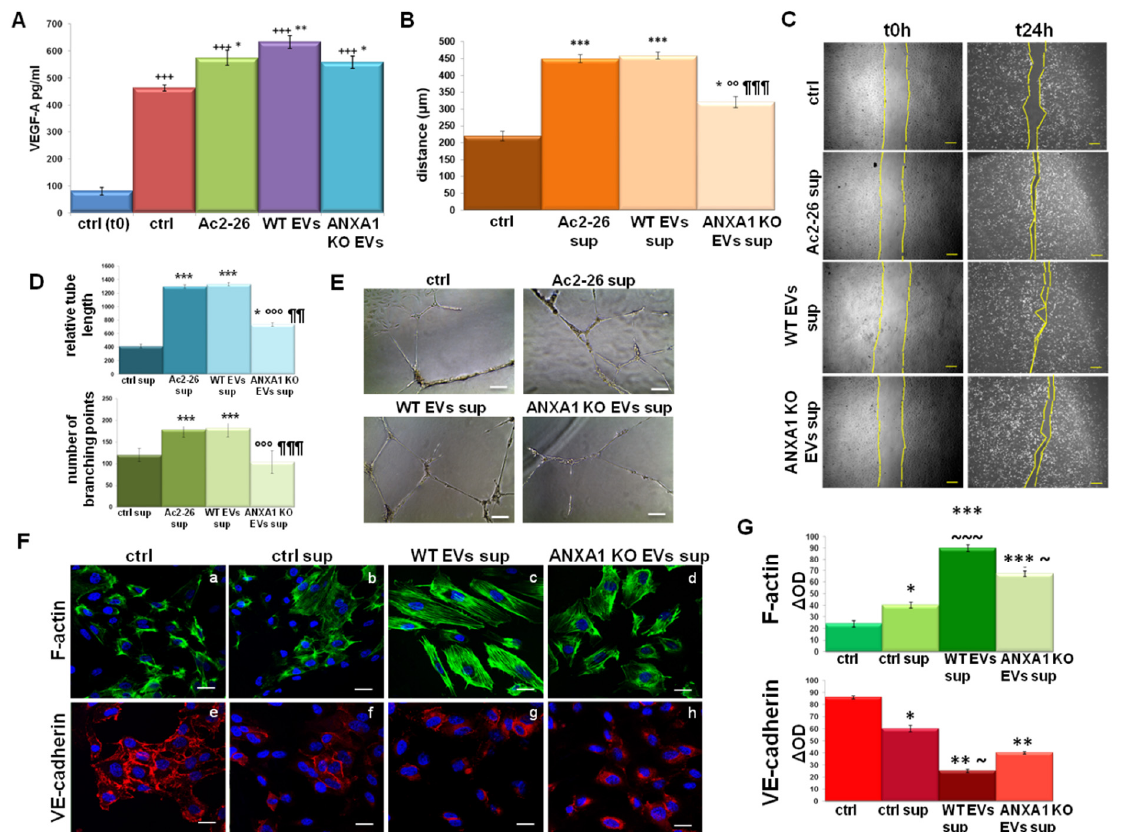
Figure 4. Endothelial cells activation induced by M2 macrophages. ( A ) ELISA analysis of VEGF-A expression in the supernatants of macrophages treated with Ac2-26 (1 µM) and WT and ANXA1 KO EVs for 24 h. Result of HUVEC ( B ) migration and ( D ) in vitro angiogenesis in presence of THP-1 supernatants pretreated for 24 h with WT and ANXA1 KO MIA PaCa-2 EVs and Ac2-26 (1 µM). The relative bright field images are reported in ( C ) for migration assay (Bar = 50 µm) and in ( E ) for angiogenesis one (Bar = 100 µm). ( F ) Confocal analysis for HUVEC cells: F-actin (panels a–d) and VE-cadherin (panels e–h) with the related densitometry evaluation in ( G ). Nuclei were stained with DAPI 1:1000 for 30 min at RT in the dark. Magnification 63 × 1.4 numerical aperture (NA). Bar = 100 µm. Data represent the mean of three independent experiments ± standard deviation with similar results. * p < 0.05; ** p < 0.01; and *** p < 0.001 for treated cells vs. untreated controls; ¥¥ p < 0.01; ¥¥¥ p < 0.001 for each point with ANXA1 KO EVs vs. WT EVs; +++ p < 0.001 for each experimental point vs. baseline control t0 meaning the treatment exclusively with PMA (320 nM) for 6 h; °° p < 0.01; °°° p < 0.001 for ANXA1 KO EVs sup. vs. Ac2-26 sup; ¶¶ p < 0.01; ¶¶¶ p < 0.001 for ANXA1 KO EVs sup. vs. WT EVs sup; ~ p<0.05; ~~~ p < 0.001 for ANXA1 KO EVs sup. and WT EVs sup. vs. ctrl sup.